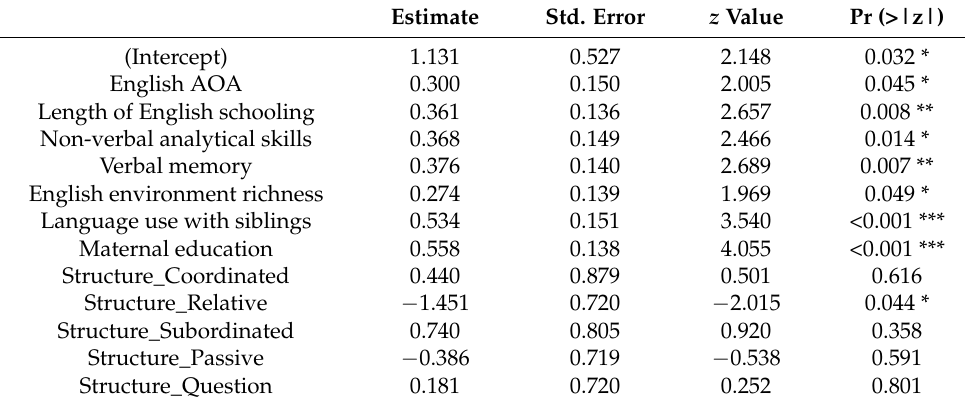
Table A8. English T1 fixed effects.